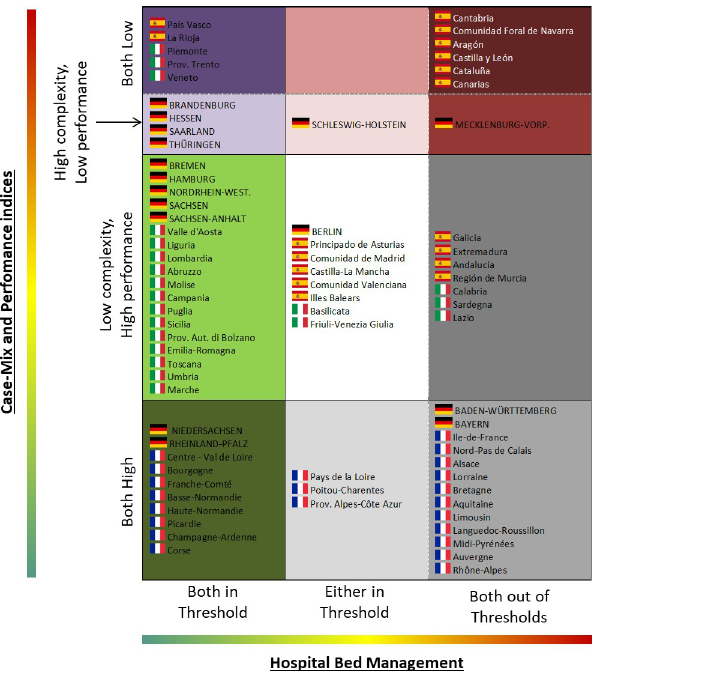
Fig 7. Classification of each region within the matrix reported in Fig